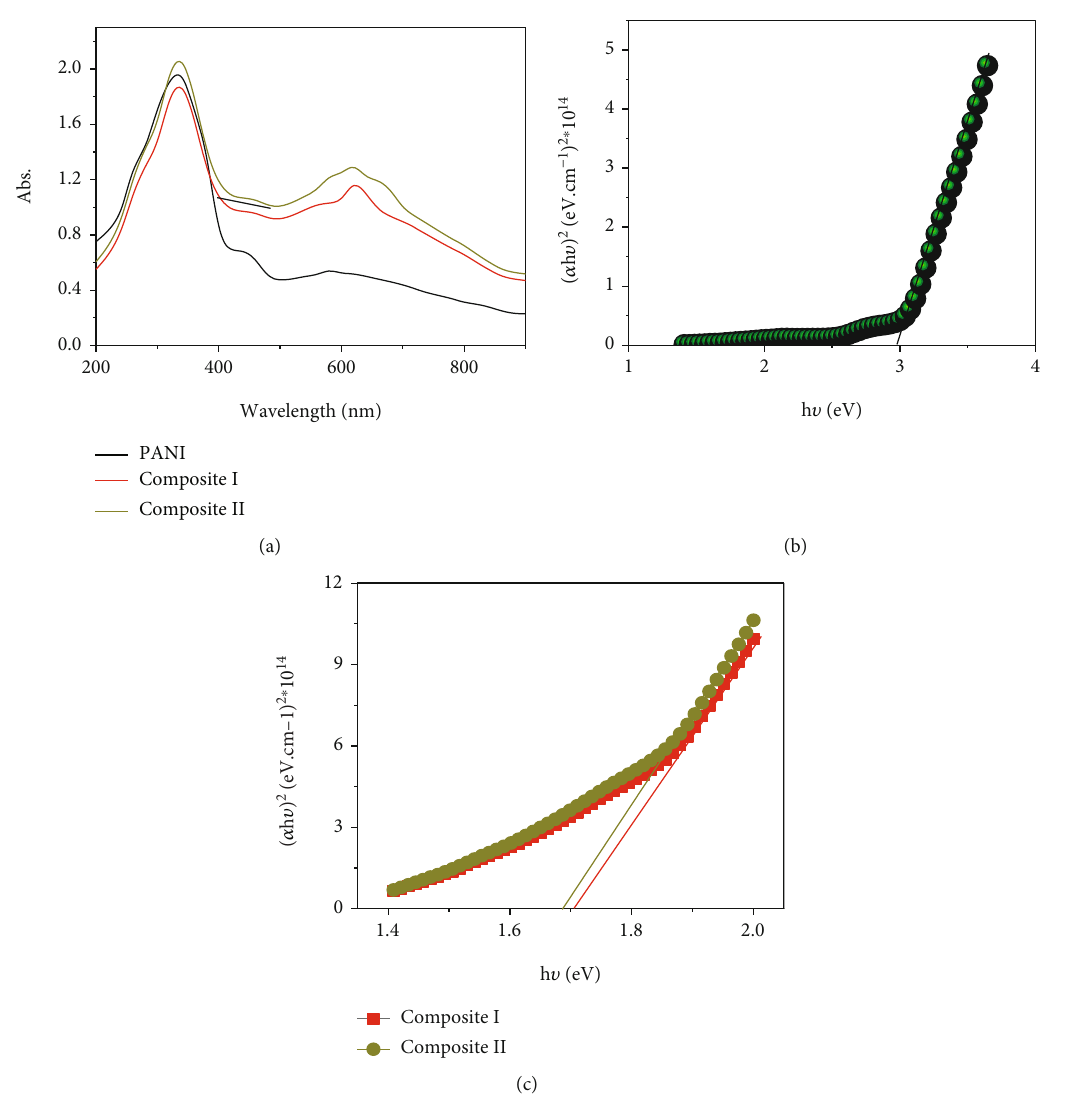
O-Ag composites I and 2